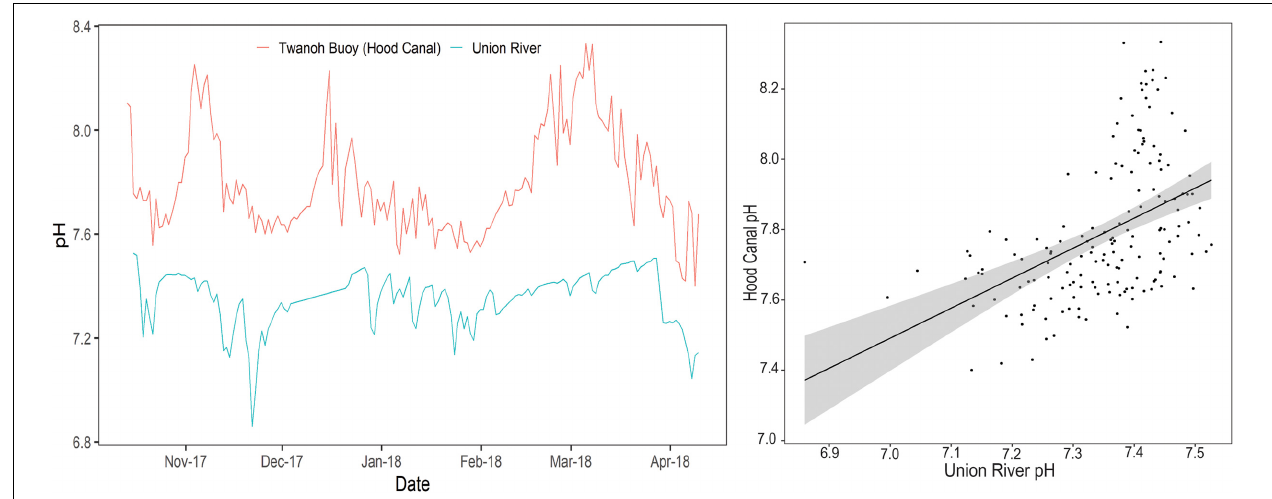
FIGURE 5 | (Left) Daily average pH in the Union River and in the Hood Canal measured at the Twanoh Buoy by (ORCA-UW, 2018) from October 13th, 2017 to April 9th, 2018. Date is displayed as Month-YY. (Right) Daily average pH in the Union River compared to the Hood Canal ( r = 0.47, p < 0.001).